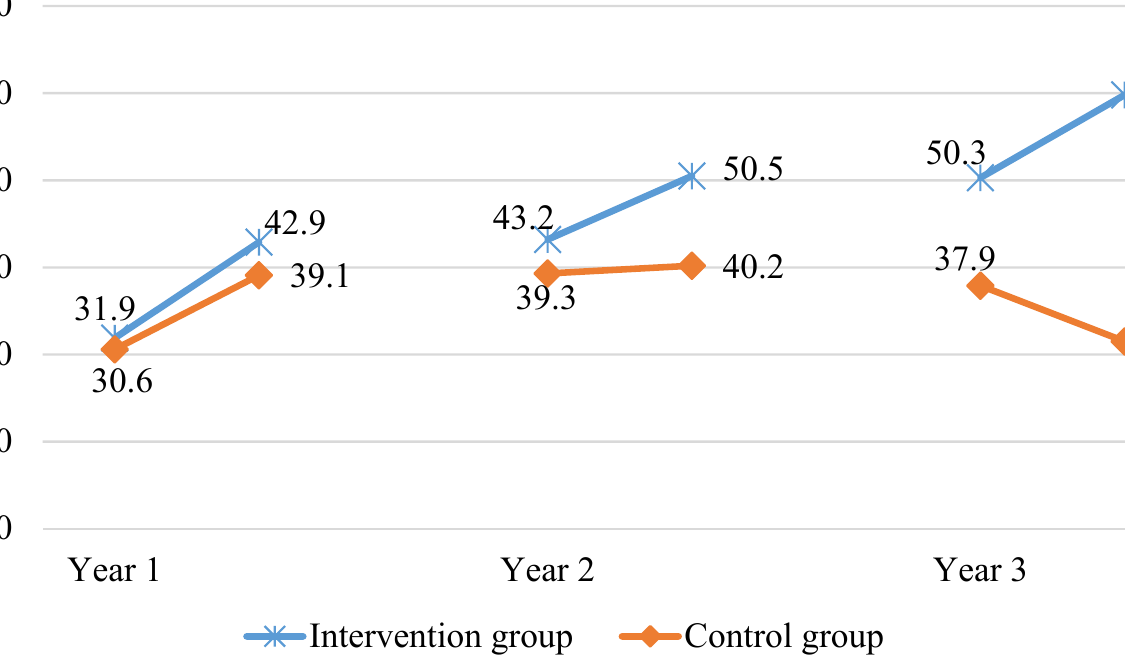
Figure 6. The proportion of children correctly answering the question “How many portions of fruit and vegetables should you eat?” during the three years of the study.